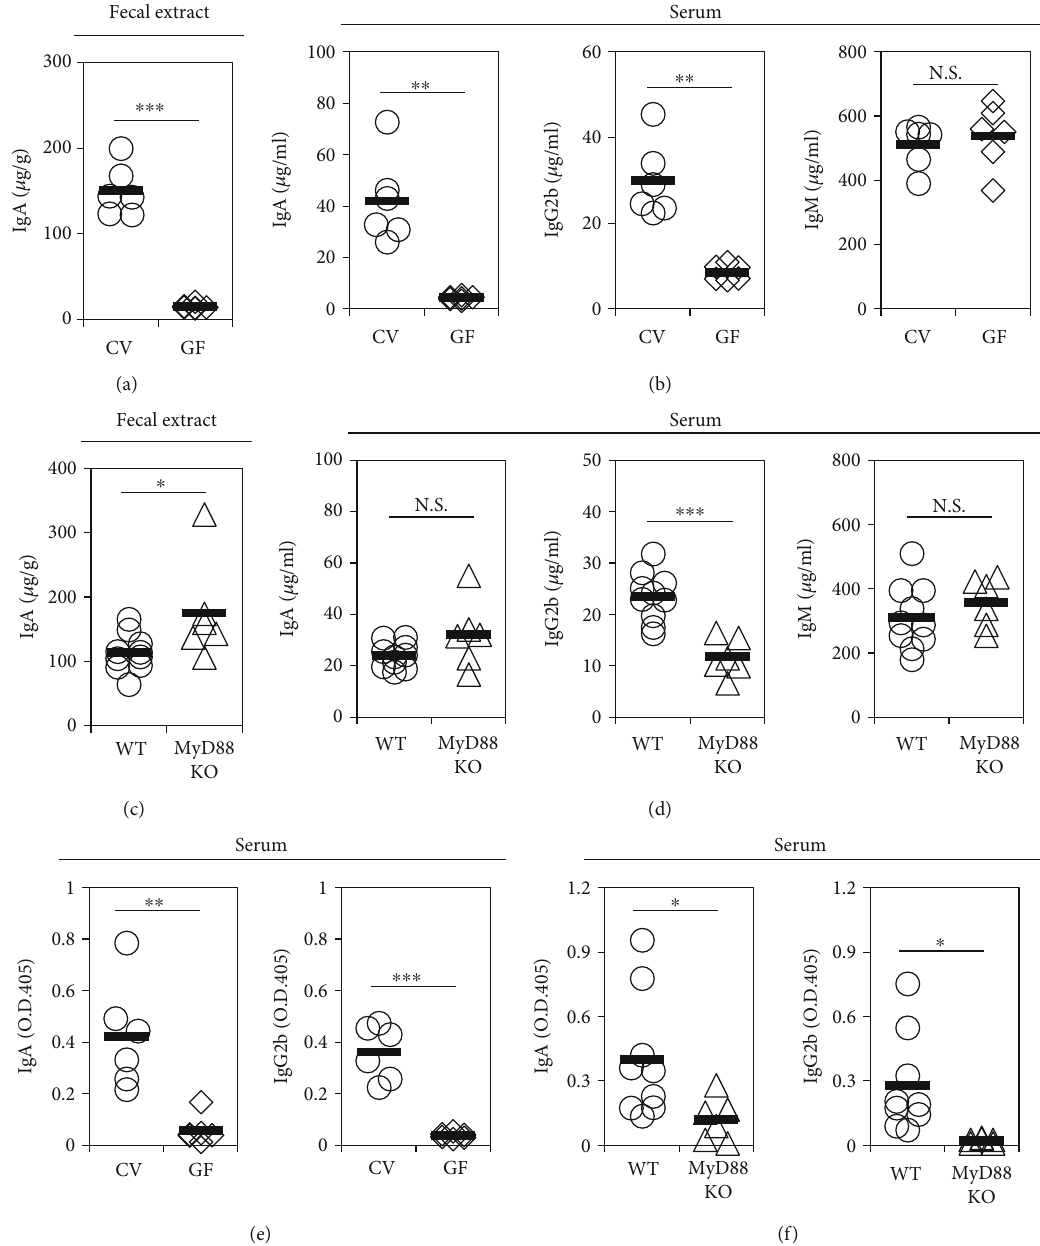
Figure 5: Levels of total and commensal microbiota-reactive antibodies in the feces and serum of the mice maintained under the di ff erent experimental conditions. The levels of total or commensal microbiota-reactive antibodies were measured by ELISA. (a) Total IgA in the fecal extract from CV and GF WT mice. (b) Total IgA, IgG2b, and IgM in serum from CV and GF WT mice. (c) Levels of total IgA in the fecal extract from SPF WT and MyD88 -/- mice. (d) Total IgA, IgG2b, and IgM in serum from SPF WT and MyD88 -/- mice. (e) Commensal microbiota-reactive IgA and IgG2b from CV and GF WT mice. (f) Commensal microbiota-reactive IgA and IgG2b from SPF WT and MyD88 -/- mice. (e, f) Antibody titers of commensal microbiota-reactive antibodies are shown as net OD405 units ( sample OD405 – meanOD405 of blanks ). The mean OD405 value of blanks was 0.13 for IgA and 0.06 for IgG2b. Data are shown as the mean ± SD of six to ten mice and are representative of at least three independent experiments. ∗ p < 0 : 05 , ∗∗ p < 0 : 01 , and ∗∗∗ p < 0 : 001